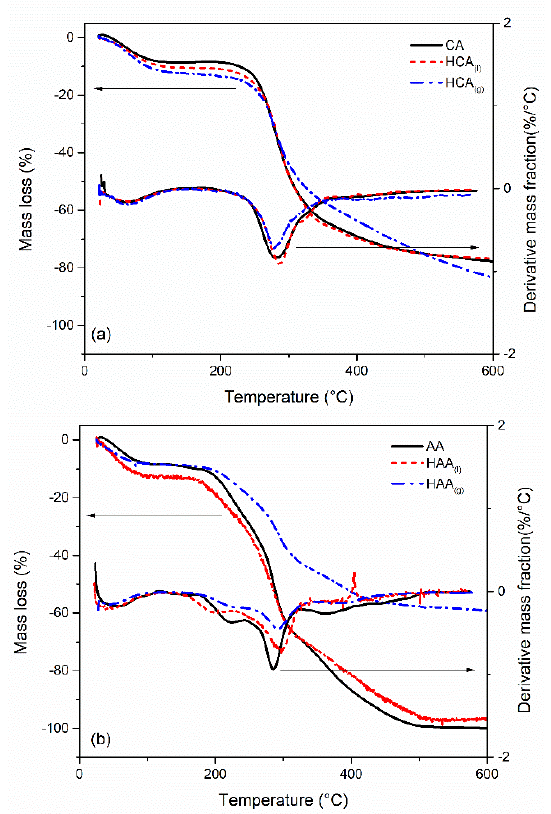
Figure 4. Thermal stability investigation. TGA and DTG profiles of pristine aerogel (black curves), LPM silanization (red curves), and GPM silanization (blue curves). ( a ) CA, pristine and after LPM and GPM treatment, ( b ) AA, pristine and after LPM and GPM treatment.